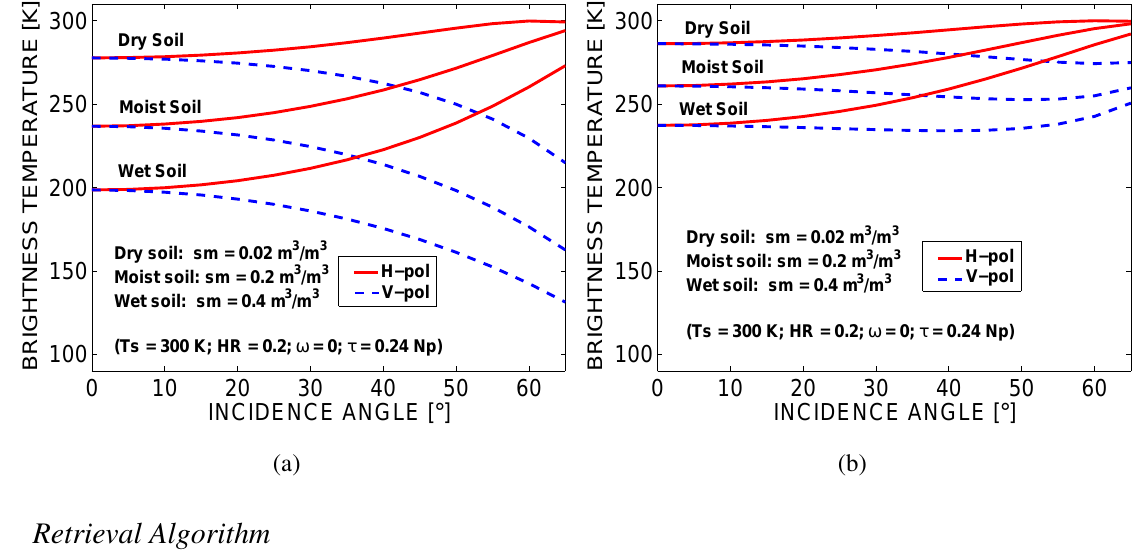
Figure 1. Graphical plots illustrating the brightness temperature dependence with incidence angle for (a) the bare soil scenarios, and (b) the vegetation-covered scenarios of Table 1, from